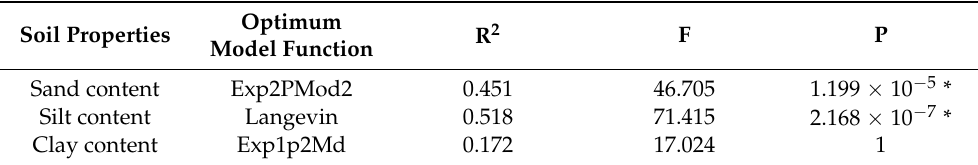
Figure 8. Correlation between particle size content and reflectance spectra of 2 atmospheric correction models under 0–40 cm soil thickness. Table 3. Regression analysis of single-band optimum fitting model for three particle